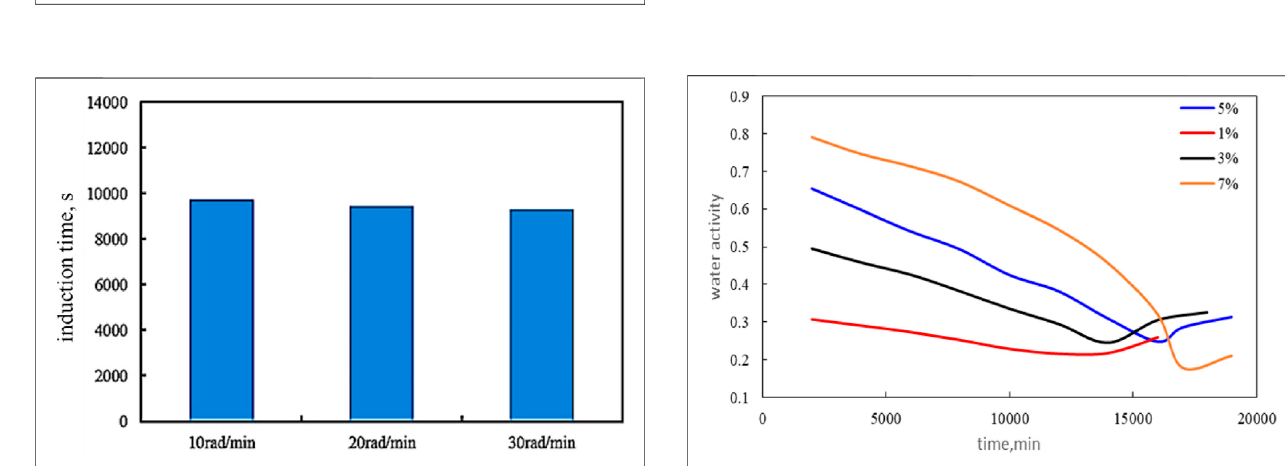
FIGURE 12 | Induction time of gas hydrate formation at different stirring speeds.